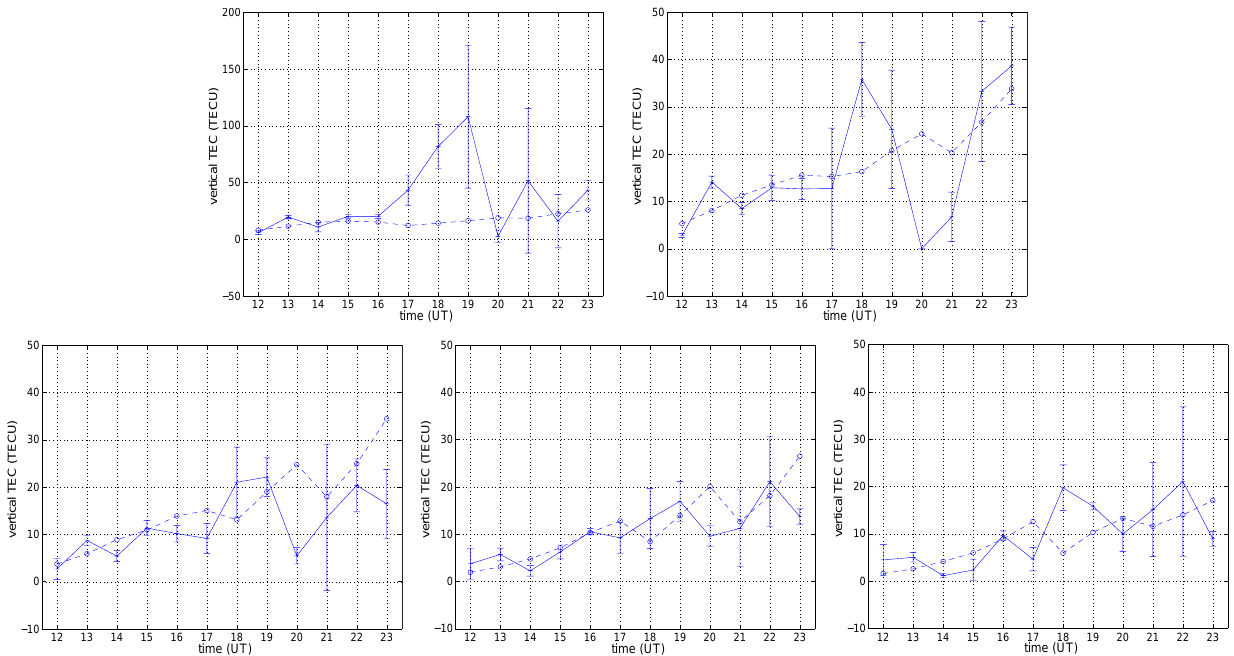
Fig. 5. VTEC profiles at 35 ◦ N between 120 ◦ W and 80 ◦ W inclusive (at 10 ◦ intervals) for 20 November 2003; the full line is the en- semble mean from MIDAS with error bars at 95% confidence level; the dashed line is the optimal match with SAMI2 (1TECU=1 × 10 16 electrons/m 2